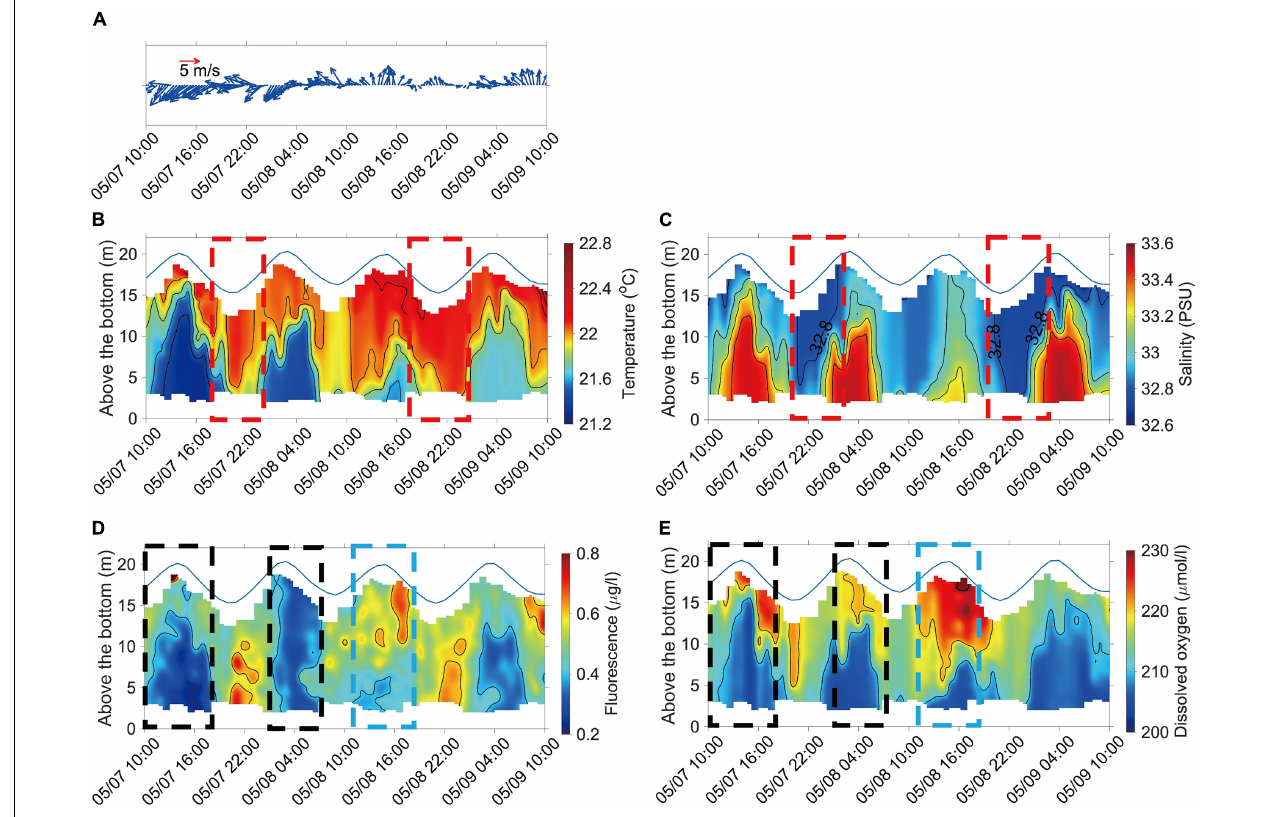
FIGURE 3 | Fixed-point shipboard observations of (A) wind speed and direction (plotted according to the oceanographic convention, north direction is upward, and the scale of the sticks is also shown in the upper left corner; vertical structures of (B) temperature; (C) salinity; (D) fluorescence; (E) dissolved oxygen (DO). The blue curve shows the fluctuations of the water depth. The red dashed rectangles indicate the time of strong river effluent events. The black dashed rectangles indicate vertically well mixed events of fluorescence values. The blue dashed rectangles indicate the corresponding event of fluorescence and DO